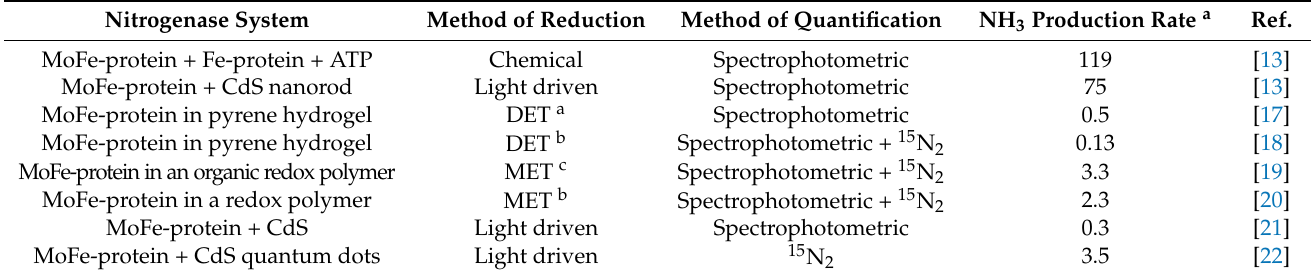
Table 1. Rate comparison for ammonia production by ATP-free and Fe-protein-free systems using only the